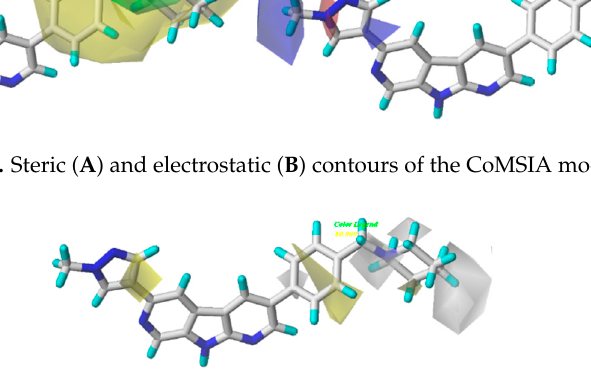
was in agreement with the contour map. The cyan color around the N-1 position of piperidine ring (R 2 to that of the hydrophobic contour plot.